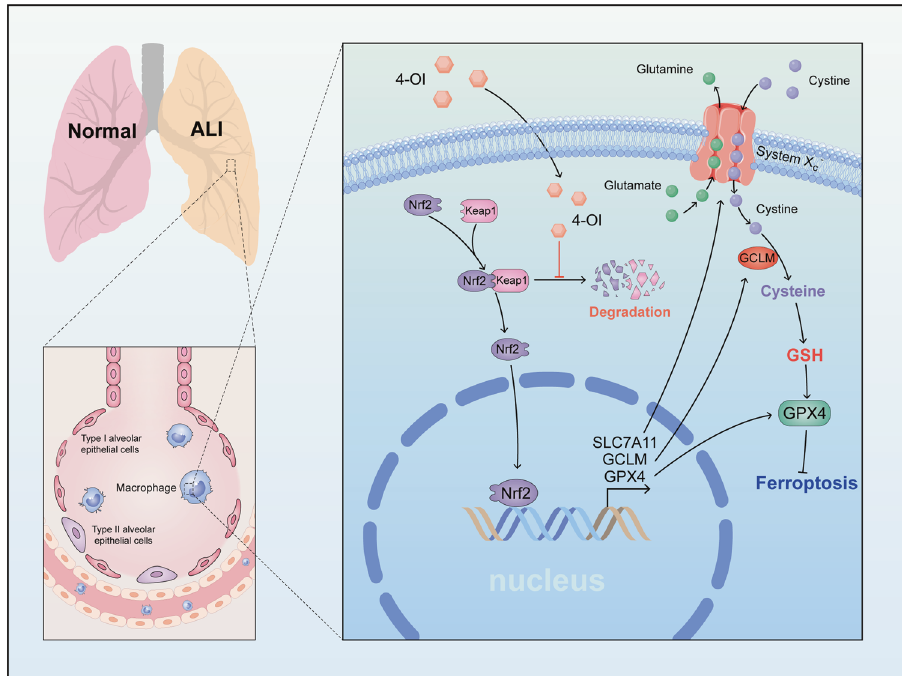
Fig. 7 Graphical abstract of 4-OI alleviate sepsis-induced ALI. In macrophages, 4-OI inhibited Nrf2 degradation and promoted the transcription of target genes, including SLC7A11, GCLM and GPX4. They contributed to inhibiting the ferroptosis induced by LPS and alleviated sepsis-induced